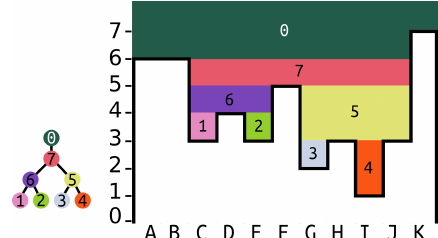
Figure 1. A single subtree of a depression hierarchy and the depres- sion it represents. Depressions 1–4 are leaf depressions. Depression 6 is a parent depression (also termed a meta-depression) that con- tains depressions 1 and 2. Water from the plateau on the left above cells A and B might fill depression 1 (cell C), causing it to spill into depression 2 (cell E). Only when both depressions are full do they merge and begin filling depression 6 (cells C, D, and E). Modified from Barnes et al. (2020).